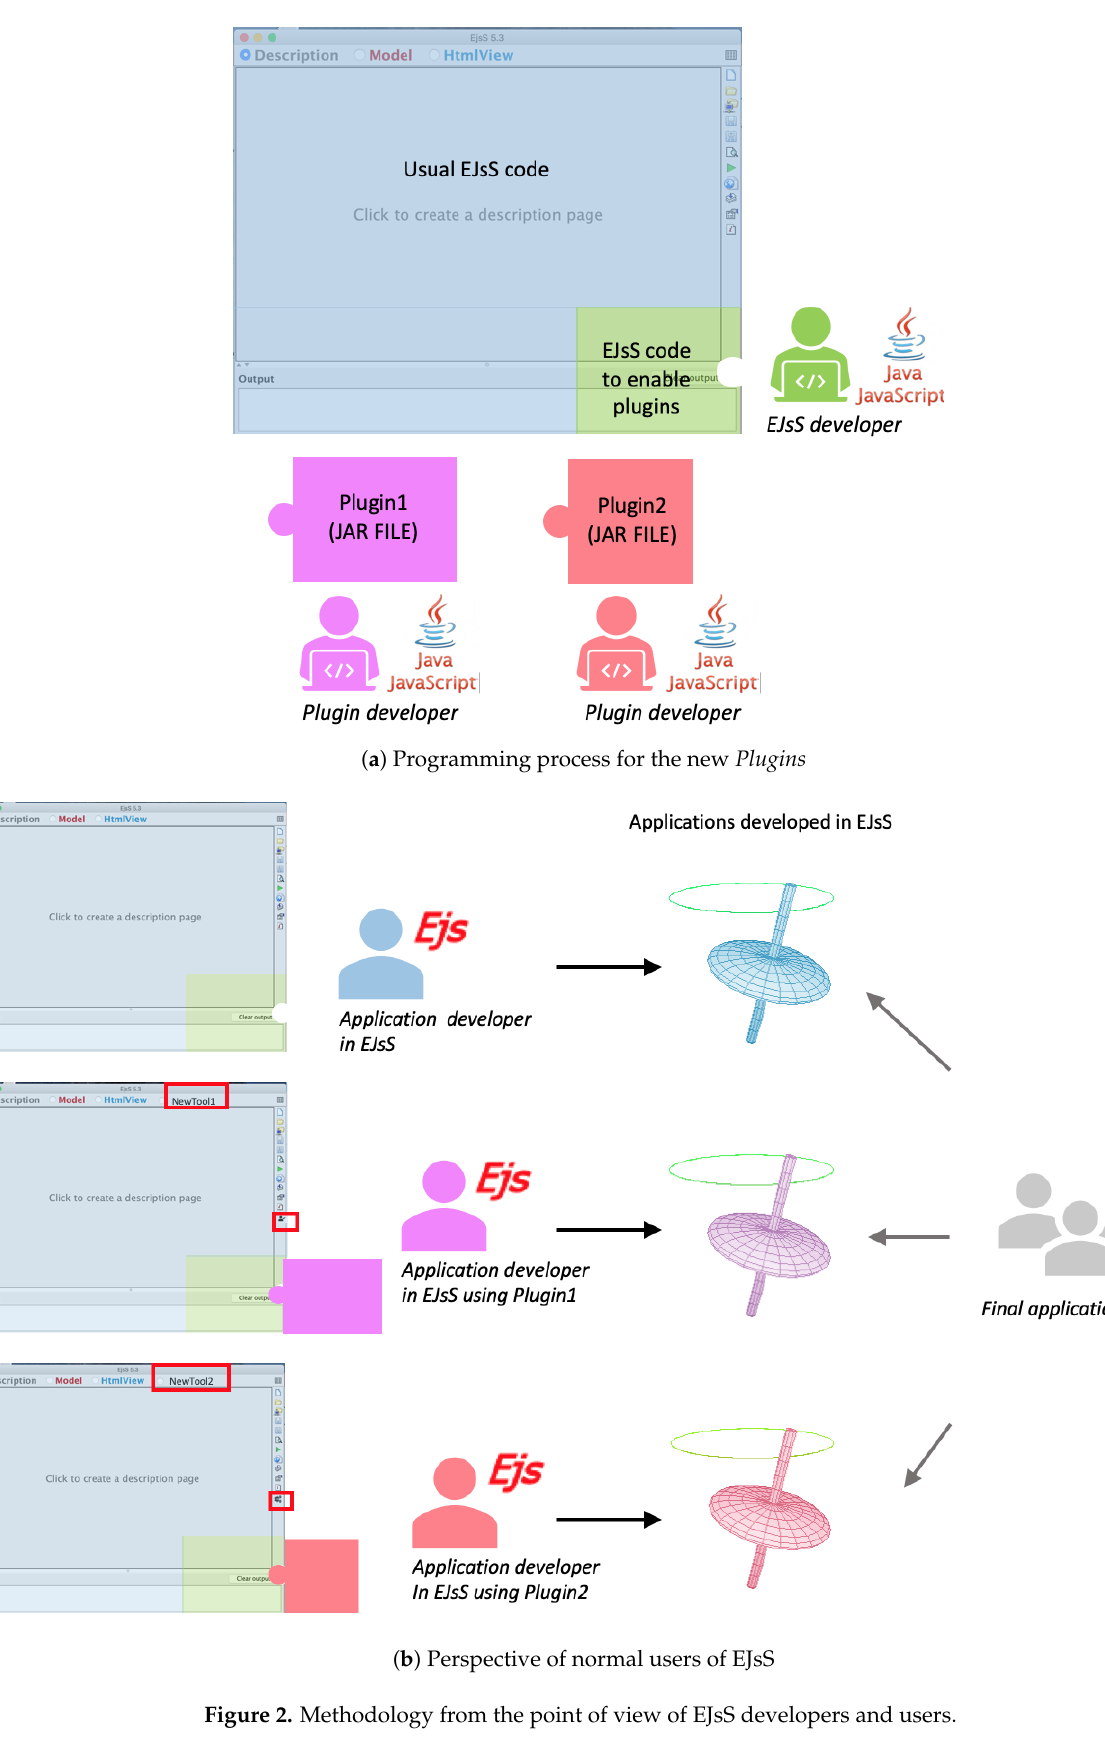
Figure 2. Methodology from the point of view of EJsS developers and